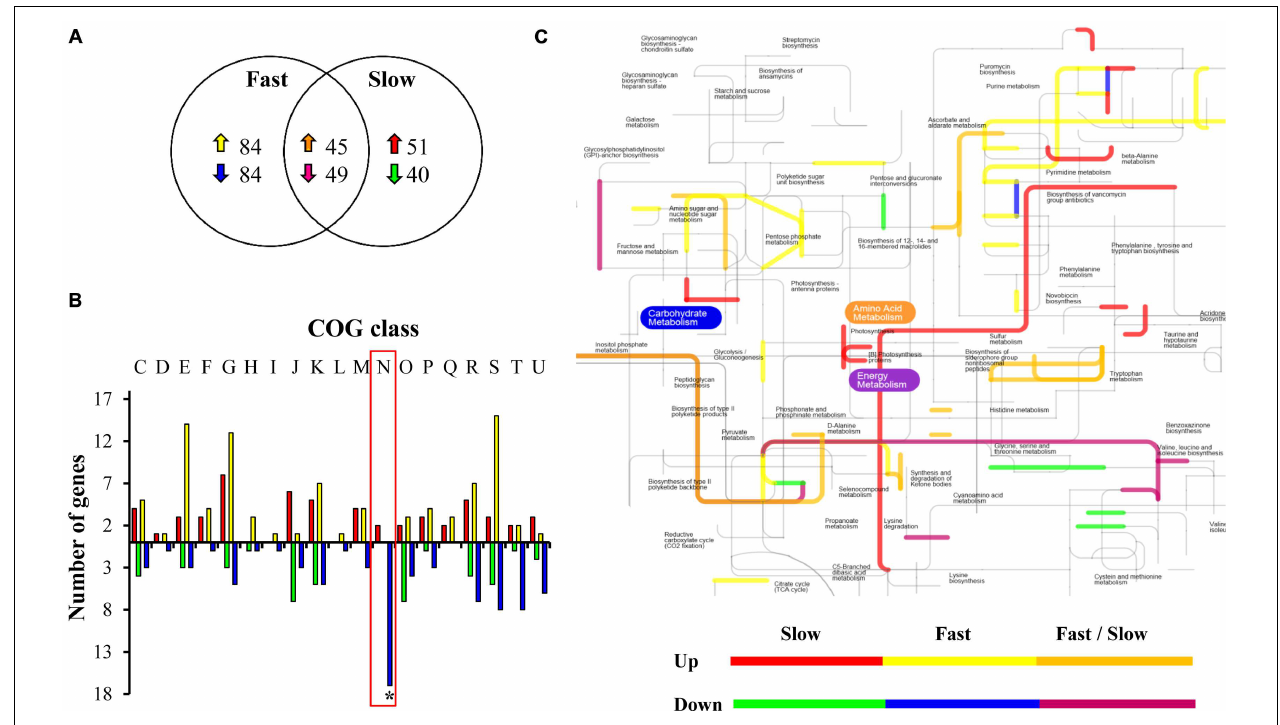
FIGURE 2 | Analysis of the transcriptional response of L. monocytogenes at low temperature. (A) Venn diagram of common and unique sets of genes differentially expressed in L. monocytogenes strains belonging to fast or slow groups at 8 vs. 30 ◦ C. Up arrows indicate over expressed genes and down arrows, repressed genes. (B) Differentially expressed genes in fast and slow groups in response to low temperature grouped by COGs. The genes were classified into 20 COGs based on their predicted function. C: Energy production and conversion; D: Cell cycle control, cell division, chromosome partitioning; E: Amino acid transport and metabolism; F: Nucleotide transport and metabolism; G: Carbohydrate transport and metabolism; H: Coenzyme transport and metabolism; I: Lipid transport and metabolism; J: Translation, ribosomal structure and biogenesis; K: Transcription; L: Replication, recombination and repair; M: Cell wall/membrane/envelope biogenesis; N: Cell motility; O: Post-translational modification, protein turnover, chaperones; P: Inorganic ion transport and metabolism; Q: Secondary metabolite biosynthesis, transport and catabolism; R: General function prediction only; S: Function unknown; T: Signal transduction mechanisms; U: Intracellular trafficking, secretion, and vesicular transport; V: Defense mechanisms. The asterisk indicates a significant difference between the fast and the slow group. (C) Metabolic pathway activated in response to low temperature unique and shared between strains belonging to low and high temperature. Fast strains: LIST 2-2 and APA 13-2 and slow strains: AL 157-12 and BS